Question: Which visualization type does this figure use?
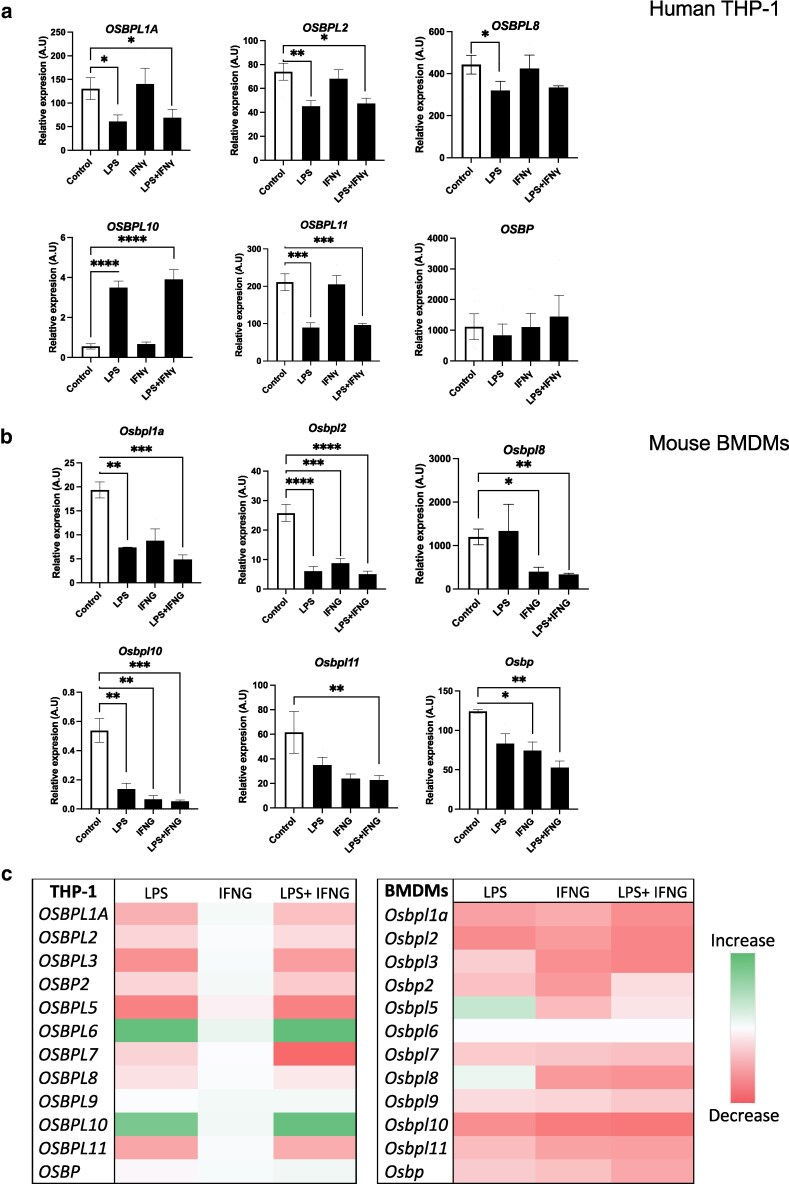
Answer: heatmap